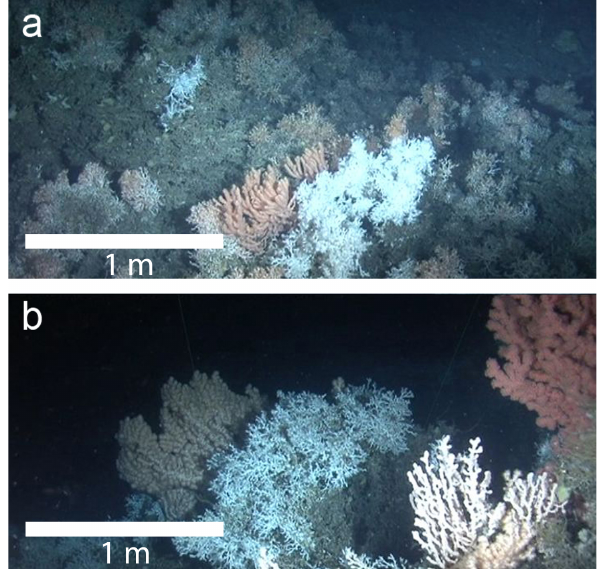
Fig. 1. Lophelia pertusa colony at the Røst Reef, Norway. (a) typ- ical “cauliflower” growth form at the Røst Reef, with live polyps facing into the prevalent current direction. (b) The downstream side of the “cauliflower” reef structure. The upper ∼ 25cm of each cauliflower is made up of living Lophelia pertusa ; the remainder the dead skeletal structure of previous polyp generations. Image cour- tesy of IFM-GEOMAR JAGO team.